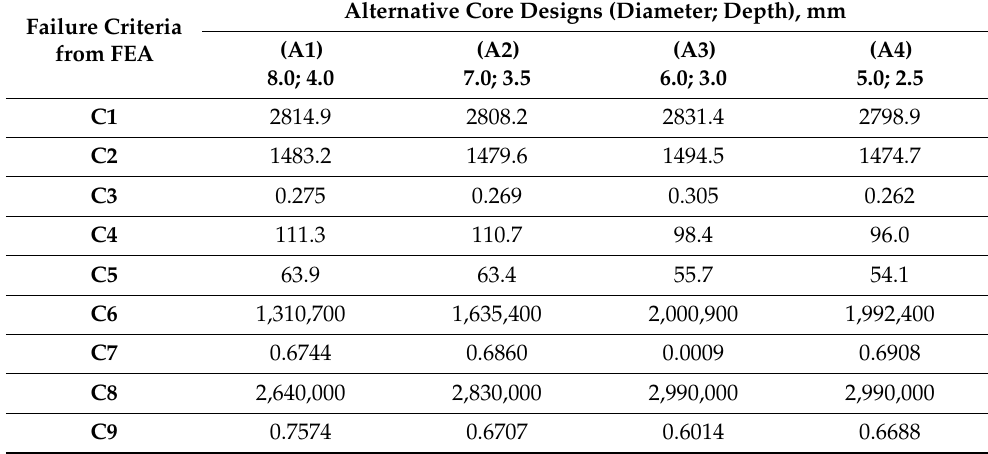
Table 6. FEA results for all the alternative core designs under cyclic loading conditions of 50%. Failure Criteria from